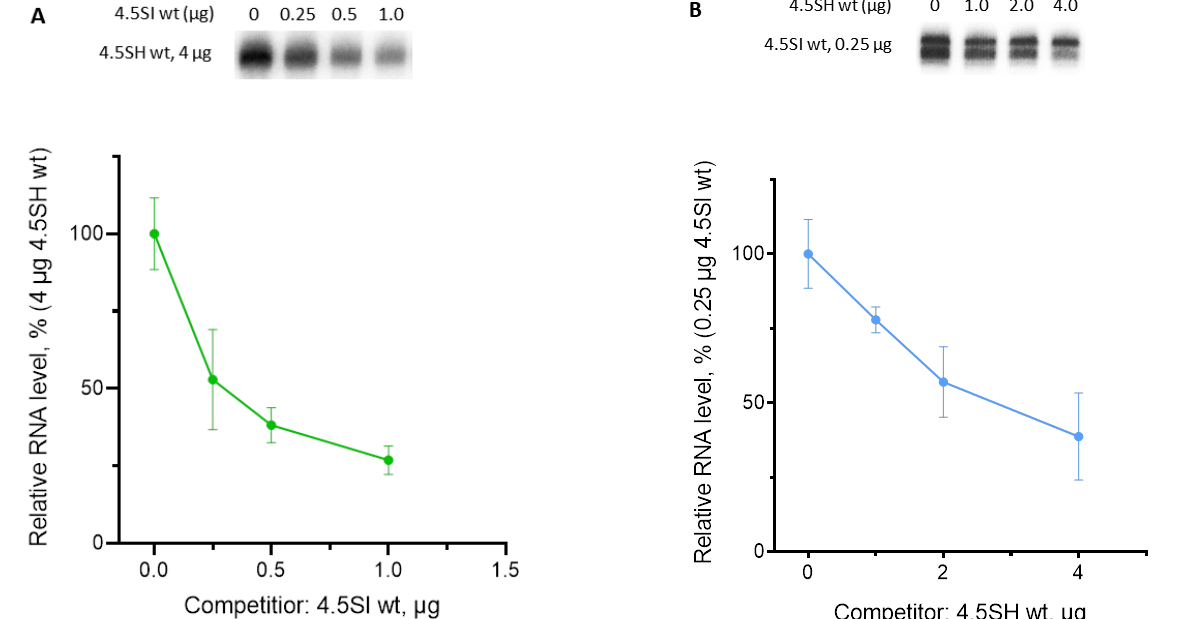
Figure 6. Transcriptional competition of wild-type 4.5SH and 4.5SI genes in transfected HeLa cells. ( A ) Detection of 4.5SH RNA via Northern hybridization. The target plasmid containing the 4.5SH gene (4 µ g) was added to each transfection sample, and the amount of the competitor plasmid containing the 4.5SI gene in the transfection mixture is specified above the lanes. ( B ) Detection of 4.5SI RNA via Northern hybridization. The target plasmid containing the 4.5SI gene (0.25 µ g) was added to each transfection sample, and the amount of the competitor plasmid containing the 4.5SH gene in the transfection mixture is indicated above the lanes. Plots summarize the Northern hybridization data. The level of 4.5SH RNA or 4.5SI RNA without competition is taken as 100%, and the amount of the competitor is indicated on the X-axis. Error bars, SD, n = 3 (see original Northern blot images for three replicates in Figure S4).